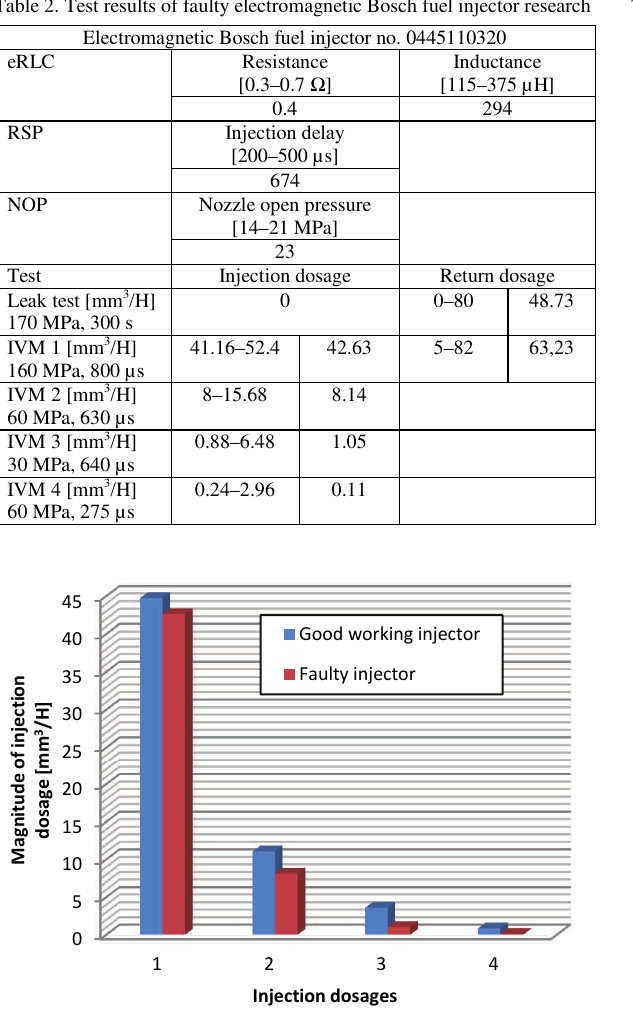
Table 2. Test results of faulty electromagnetic Bosch fuel injector research